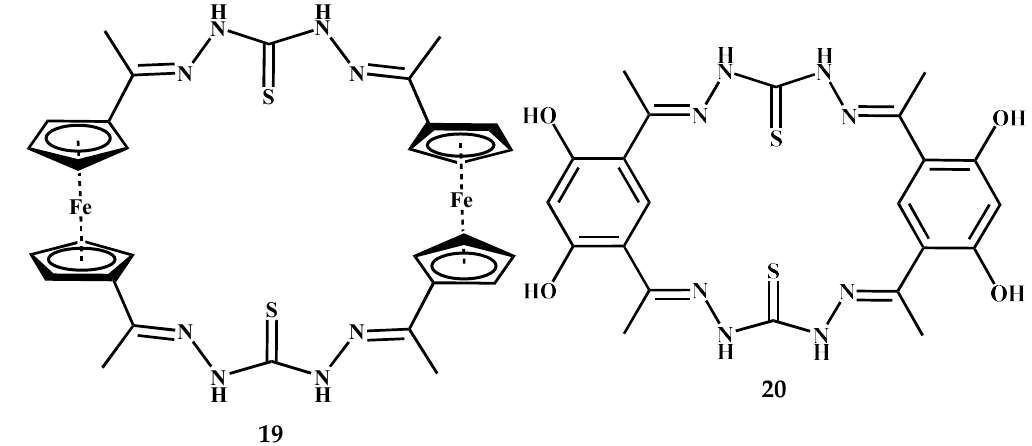
Scheme 7. Structure of macro thiocarbohydrazones.